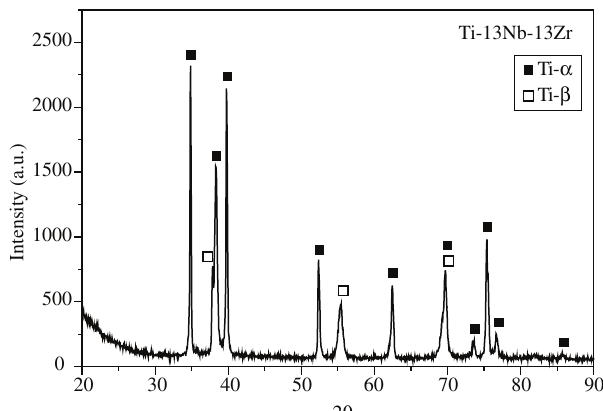
Figure 4. X-ray diffraction pattern of Ti-13Nb-13Zr alloy after sintering at 1500 °C.